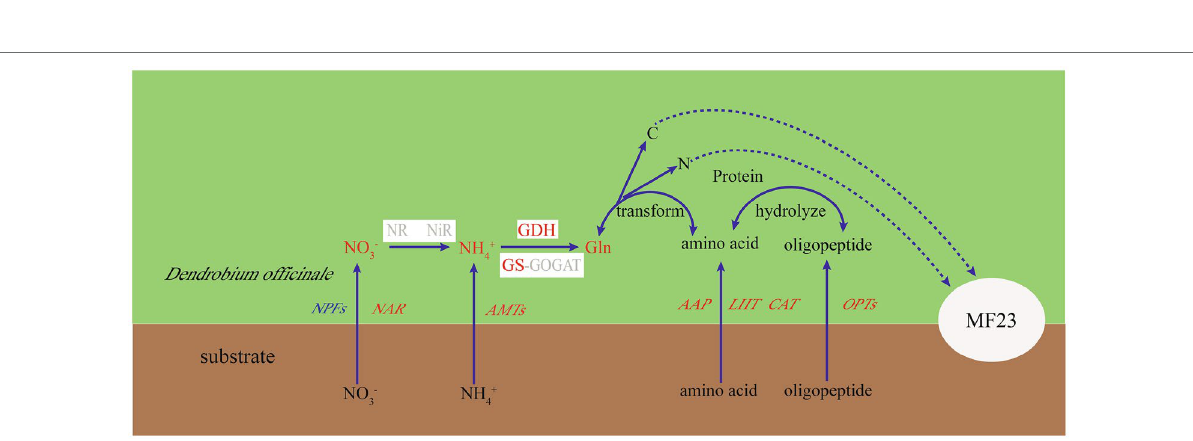
FIGURE 7 | Putative nitrogen uptake and metabolism in the D. officinale -MF23 symbiosis. Black font represents the background subjects; red, blue, and gray font represent up-, down-, and undifferentiated-regulated genes or metabolites, respectively. White boxes represent